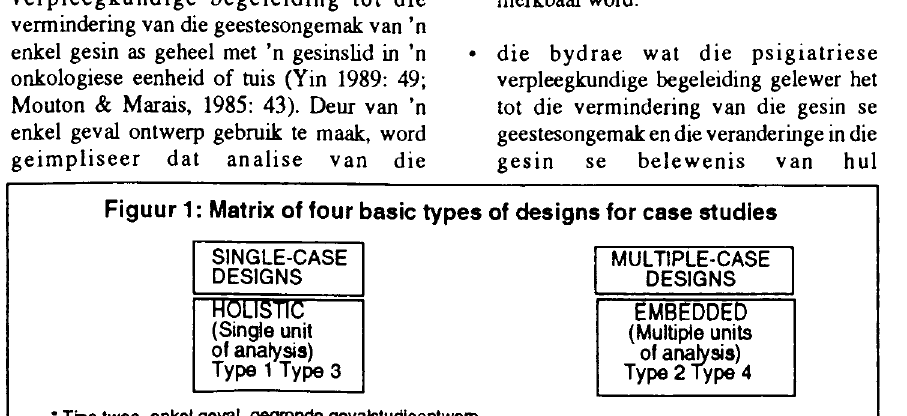
MULTIPLE-CASE DESIGNS